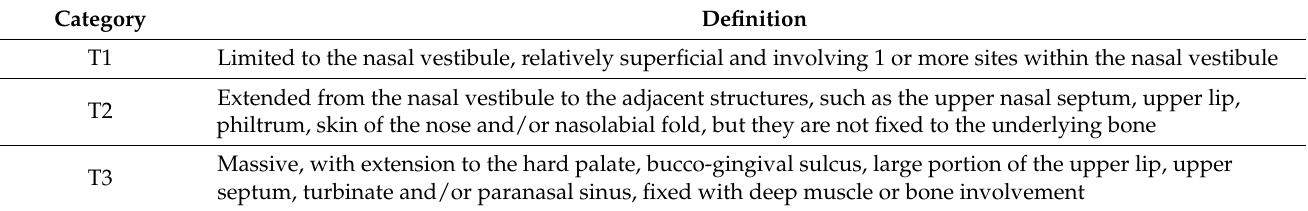
Table 4. Wang’s staging